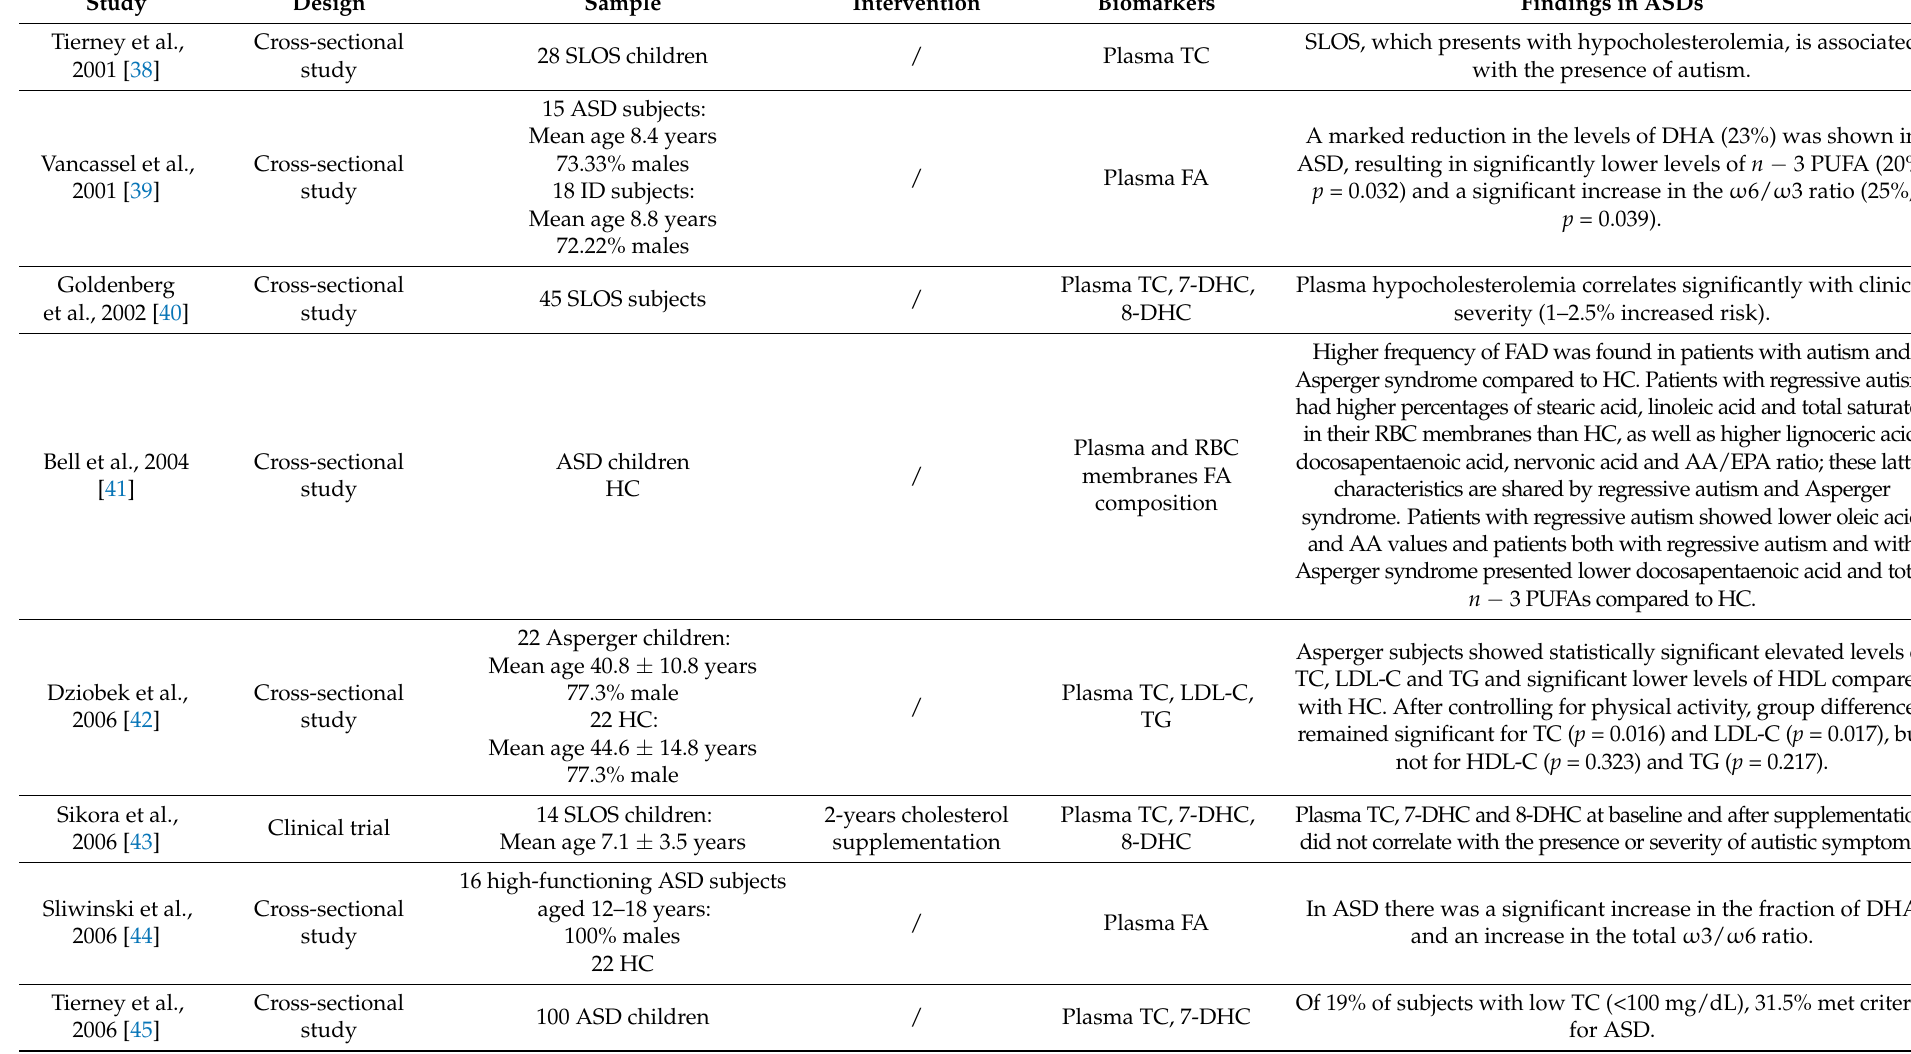
Table 1. Summary of the results of the selected studies about the role of cholesterol and fatty acids in the pathogenesis of ASDs. Study Findings in ASDs SLOS, which presents with hypocholesterolemia, is associated Plasma TC with the presence of autism.